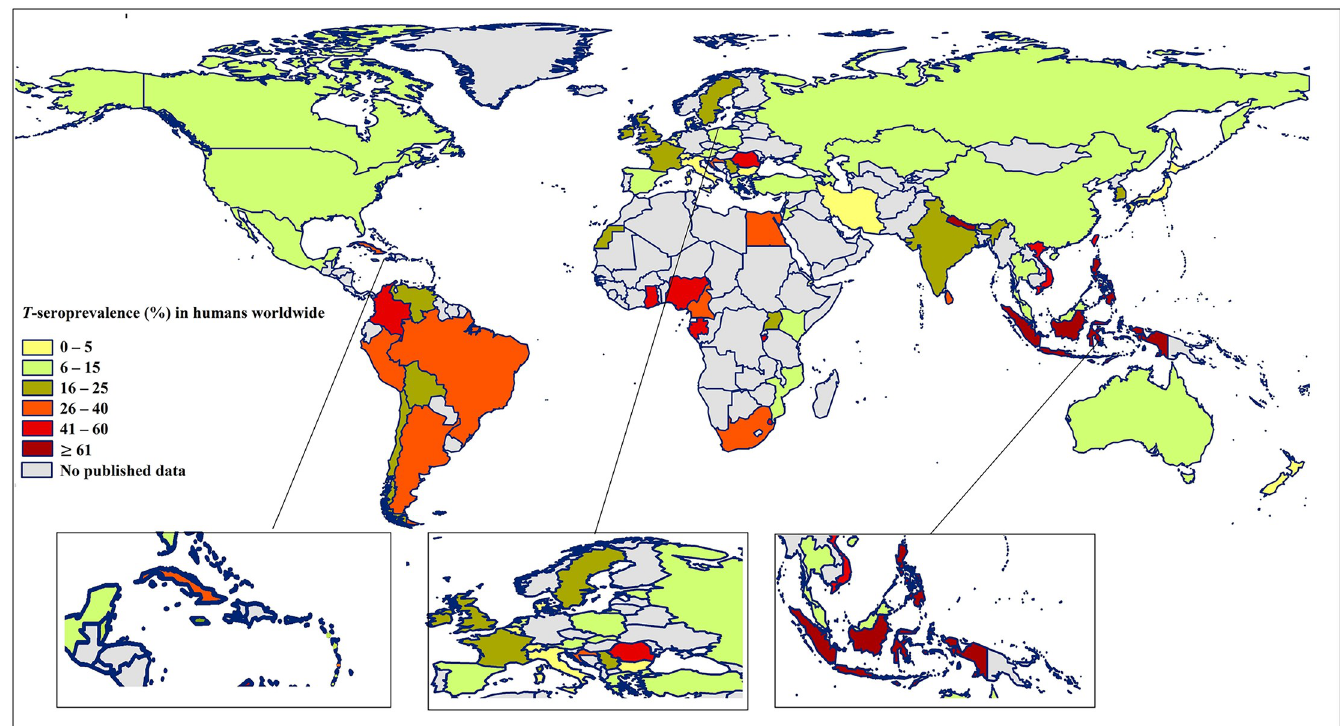
Fig 3. T -seroprevalence (%) in humans worldwide. Maps drawn by the authors; they are original and have not been published previously.